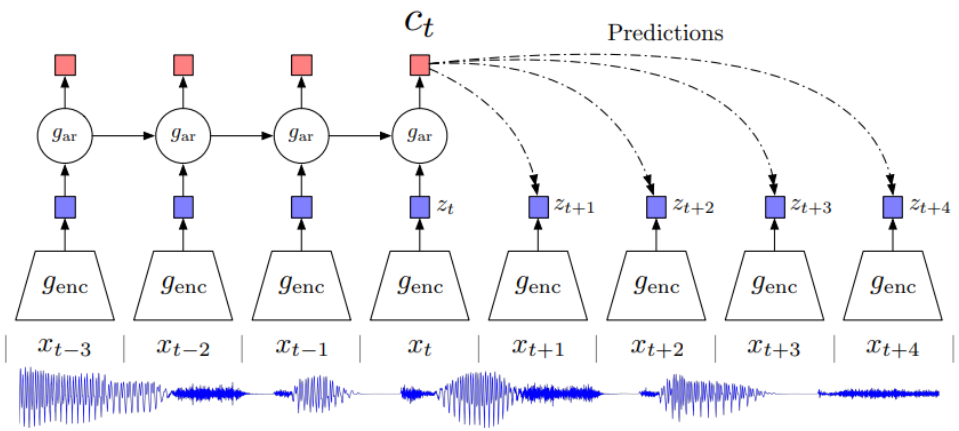
Figure 7. Contrastive Predictive Coding: Although the figure shows audio as input, similar setup can be used for videos, images, text etc.